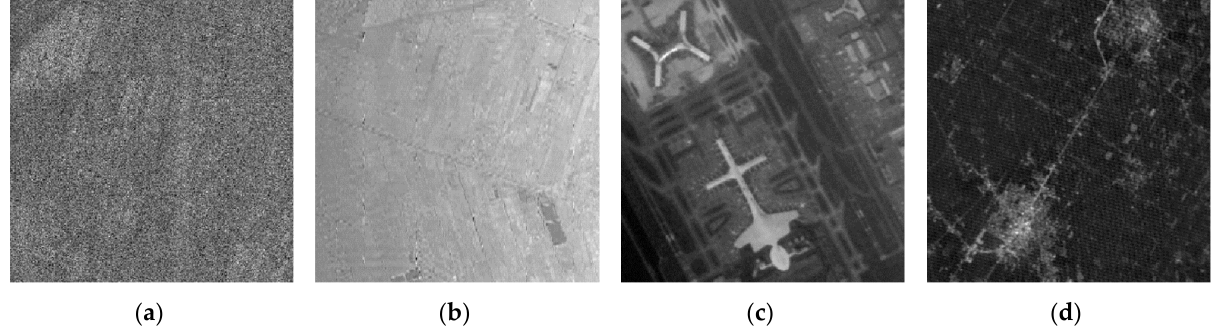
Figure 1. Noise in real satellite hyperspectral imagery: ( a ) GF-14 visible to near-infrared HSI (band 5); ( b ) GF-14 short-wave infrared HSI (band 1); ( c ) ZH-1 HSI (band 1); and ( d ) PRISMA HSI (band 66).